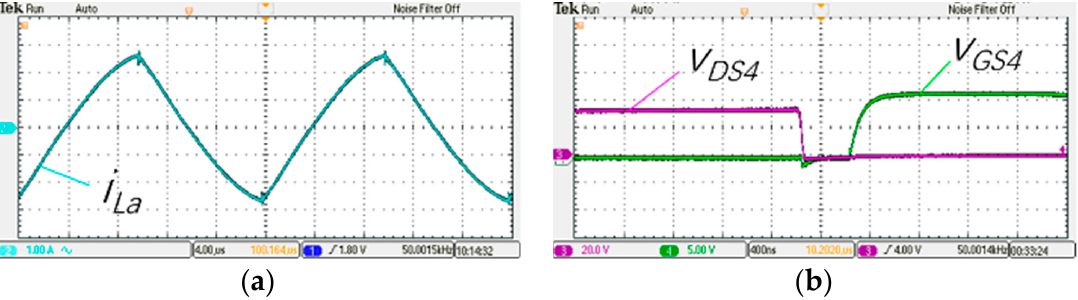
Figure 17. Injection current and lagging bridge arm waveform at 50 kHz. ( a ) Injection current; ( b ) Related waveform.